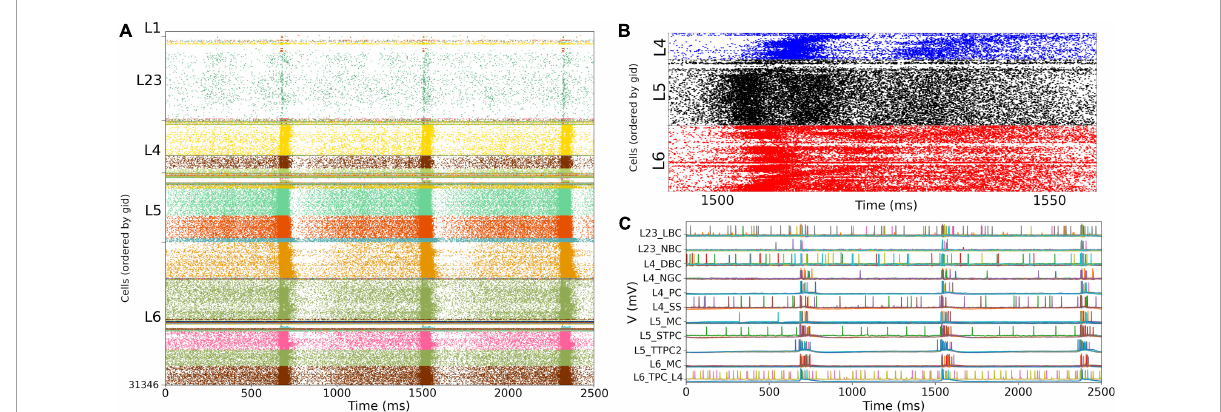
FIGURE6 NetPyNE S1 circuit response to background inputs with short-term plasticity (STP). (A) Spiking raster plot of S1 with STP. S1 and thalamus were not interconnected; only intracortical connections were included. (B) Amplified spiking raster plot (A) showing the 70 ms around the time when synchronous bursts first occur in L5 (black) and then propagate to L6 (red) and L4 (blue). (C) Example traces from (A) showing spike synchrony across cortical populations. Rasters in A show 2.5 s after steady state was reached.